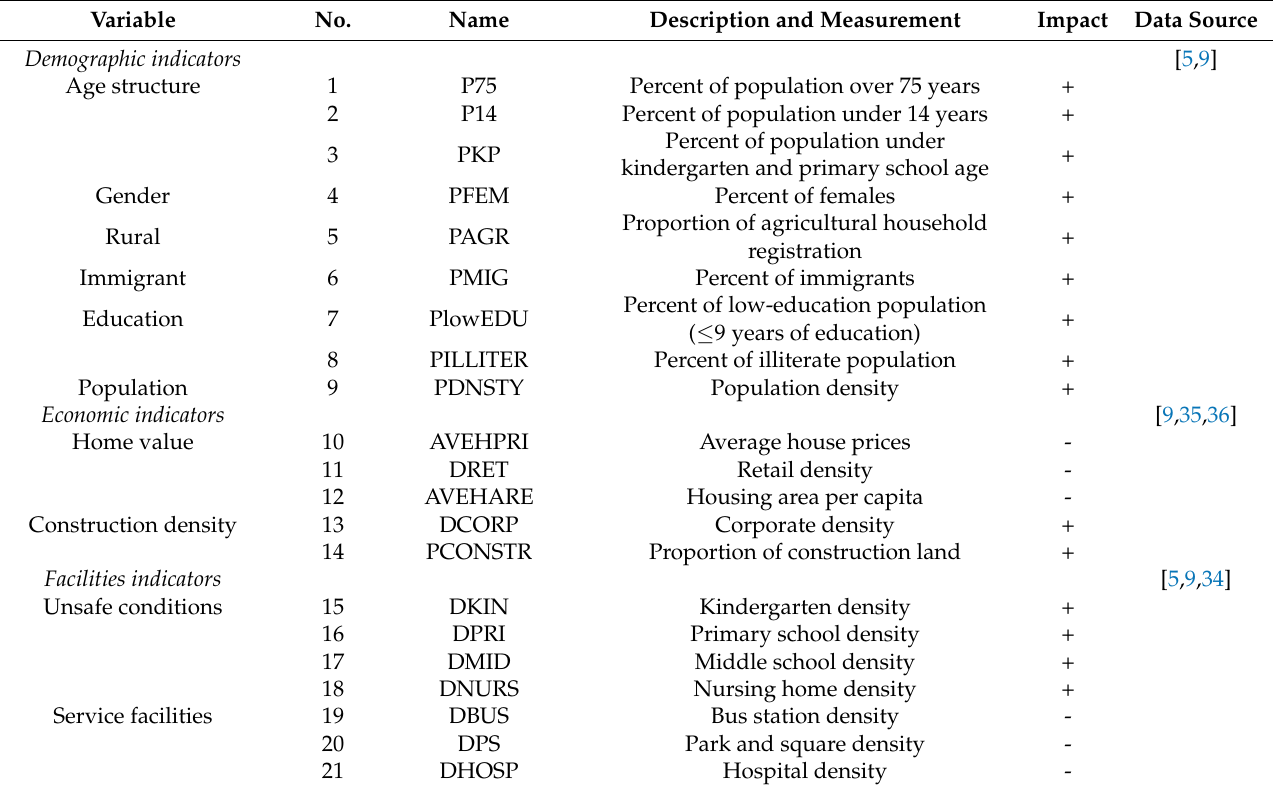
Table 1. Evaluation index system of social vulnerability in